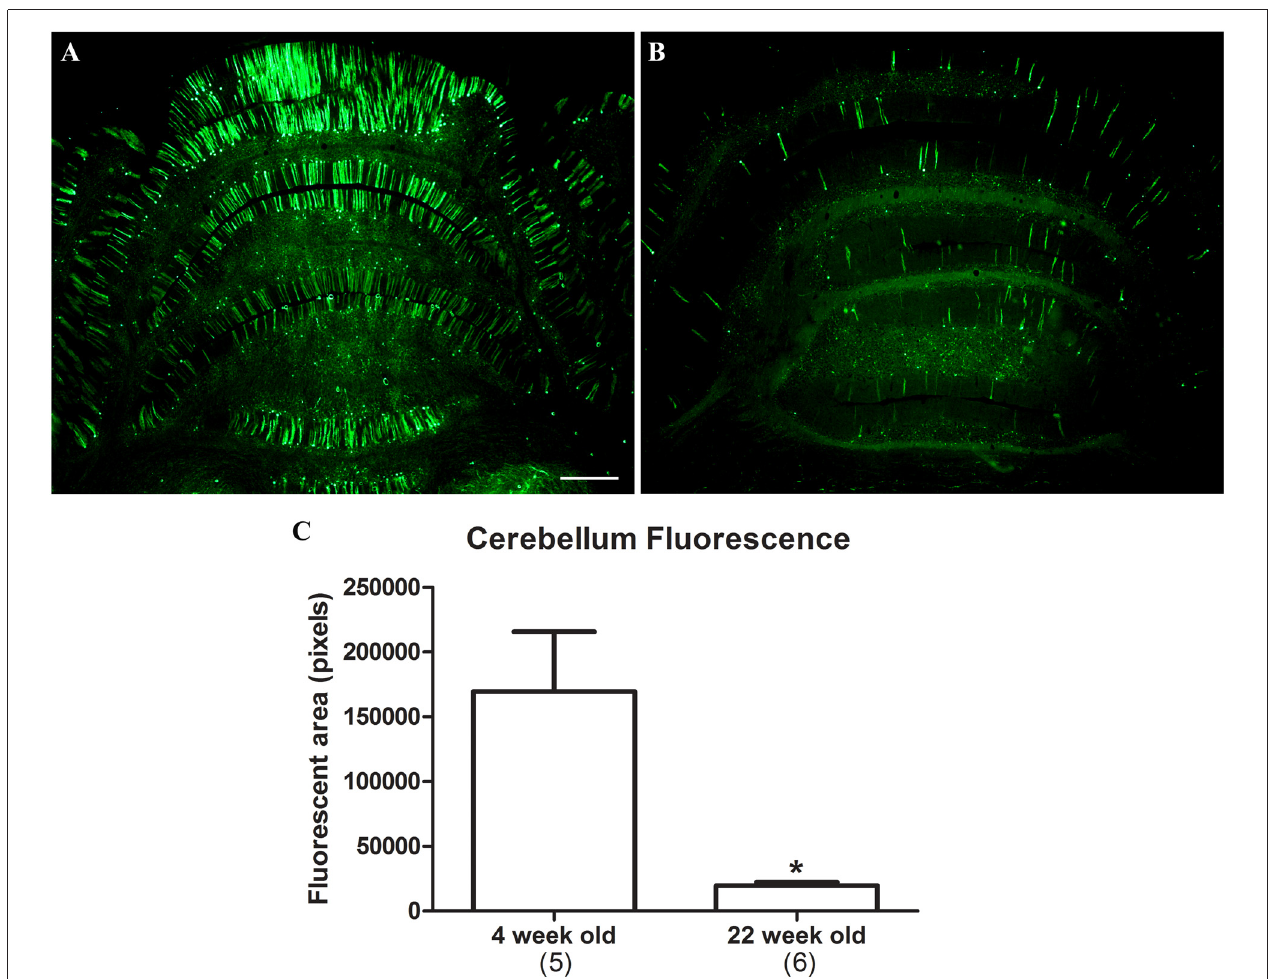
FIGURE 4 | Attenuation of synapsin promoter-driven expression at 22 weeks post gene transfer. Neonatal rats were administered synapsin promoter-AAV9 intravenously and the tissues were analyzed at time points of either 4 (A) or 22 (B) weeks. (C) The area of the cerebellum positive for GFP was compared. Lower level expression was found at the later time point ( t -test, p < 0.01, n = 5–6 /per interval). GFP immunostaining in (A,B) . Bar in (A) = 536 µ m, same magnification in (B) . ∗ Indicates p <